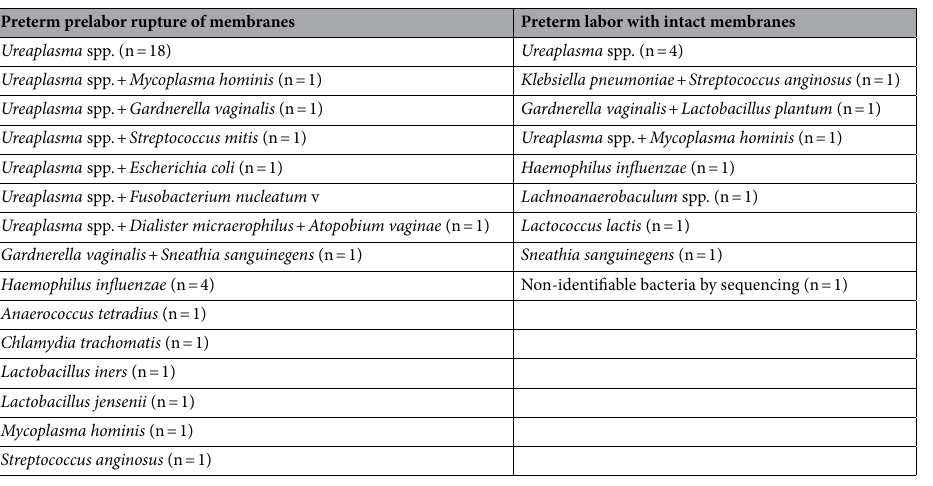
Table 3. The microbial species identified in the amniotic fluid of women with preterm prelabor rupture of membranes and with spontaneous preterm labor with intact membranes.